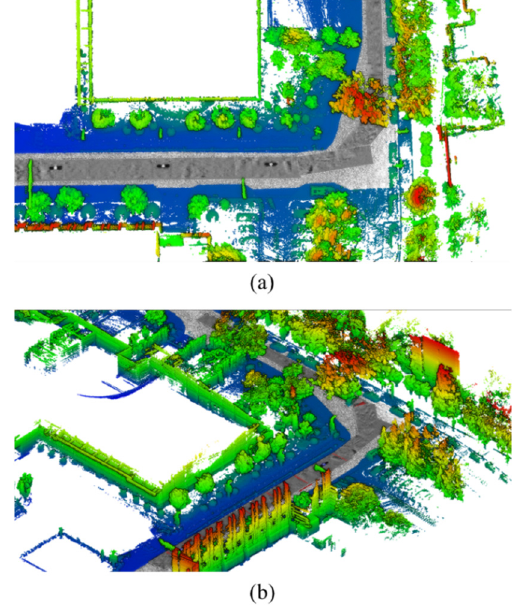
Figure 11. Part of the 3D point cloud map after